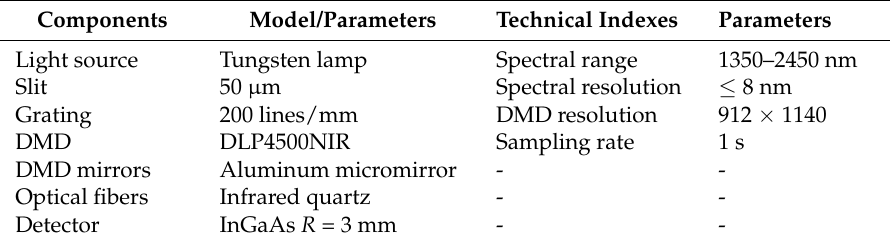
Table 1. Parameters of the HT near-infrared (NIR) spectrometer.